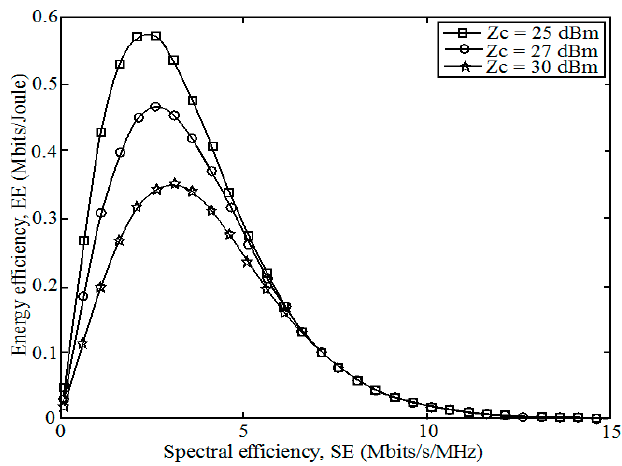
Figure 5. General relationship between SE and EE in a CCRN for different power values Z c .